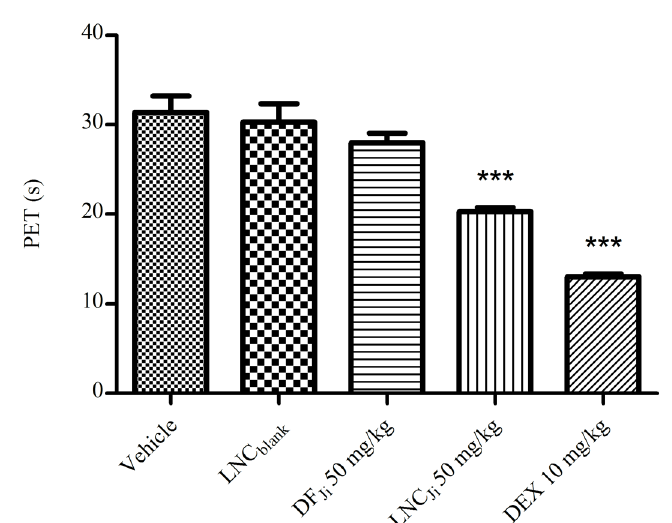
FIGURE 4 - Effects of oral administration of LNC and DF on paw elevation time (PET). The animals were treated 2 h after Ji Ji an intra-articular injection of carrageenan (300 µg/knee). The negative control group received vehicle (DMSO:PEG 400:PBS, 5:47.5:47.5) or LNC . Dexamethasone (DEX, 10 mg/kg, p.o.) was used as s positive control. *** P<0.001 represents a blank . The statistical analysis was performed using one-way ANOVA significant difference compared with the vehicle and LNC blank followed by Dunnett’s post hoc